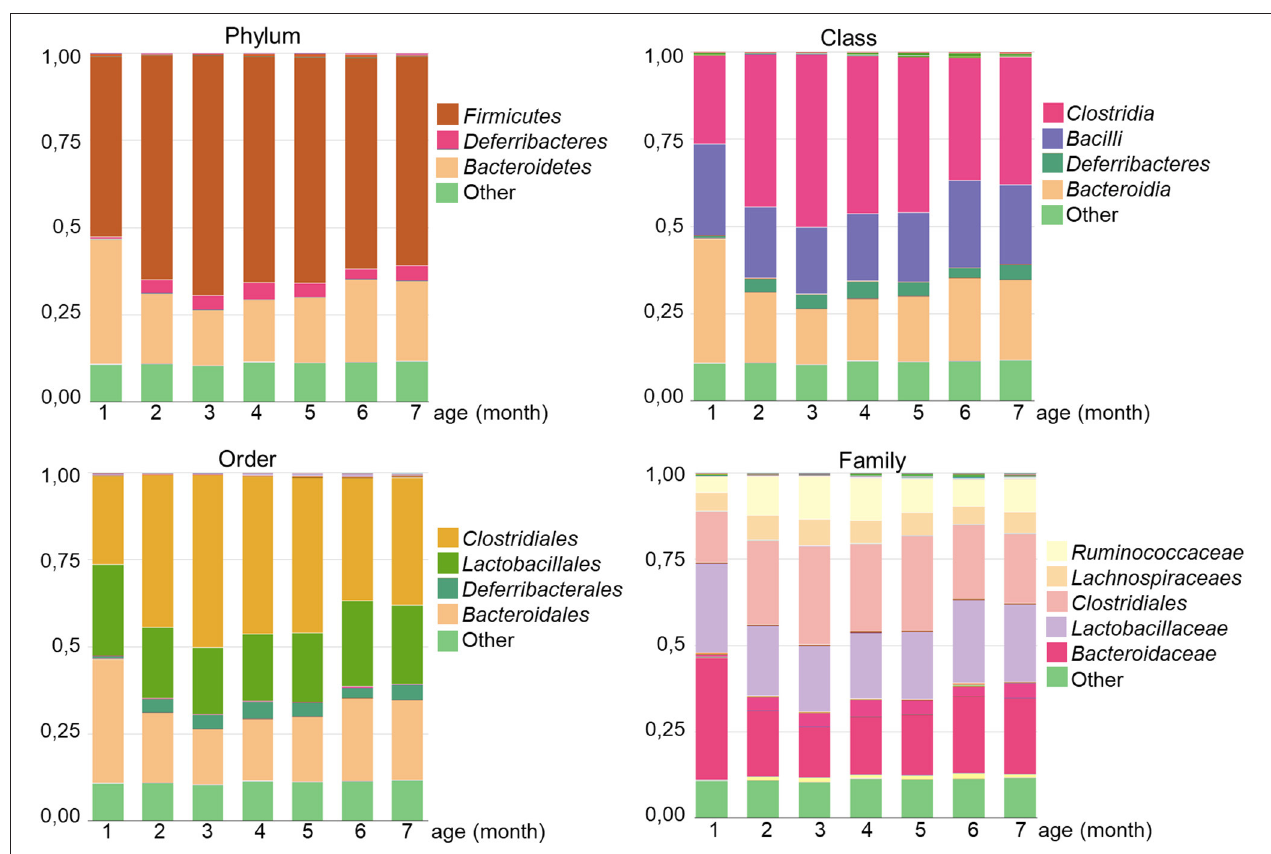
FIGURE 5 | Analysis of gut microbiota diversity in GalT-KO mice during the first 7 months of life. The different microbial proportions corresponding to each phylum, class, order, and family are shown in colors ( n =